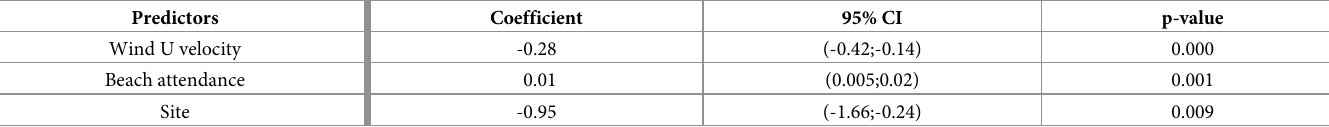
Table 2. Outputs of a backward step-wise GEE analysis with the binary sting event at Maroubra and Coogee concatenated as the response variable, in summer only. Predictors are the lagged wind zonal and meridional components, the water temperature, wave height, rip currents estimates, the ocean currents zonal and meridional components, a seasonality variable accounting for an annual cycle peaking on the 7th of February, a “site” variable (1 for Coogee, 2 for Maroubra) and the root square of the beach attendance time-series. Only significant predictors are shown with their coefficients, 95% confidence interval, and p-value.